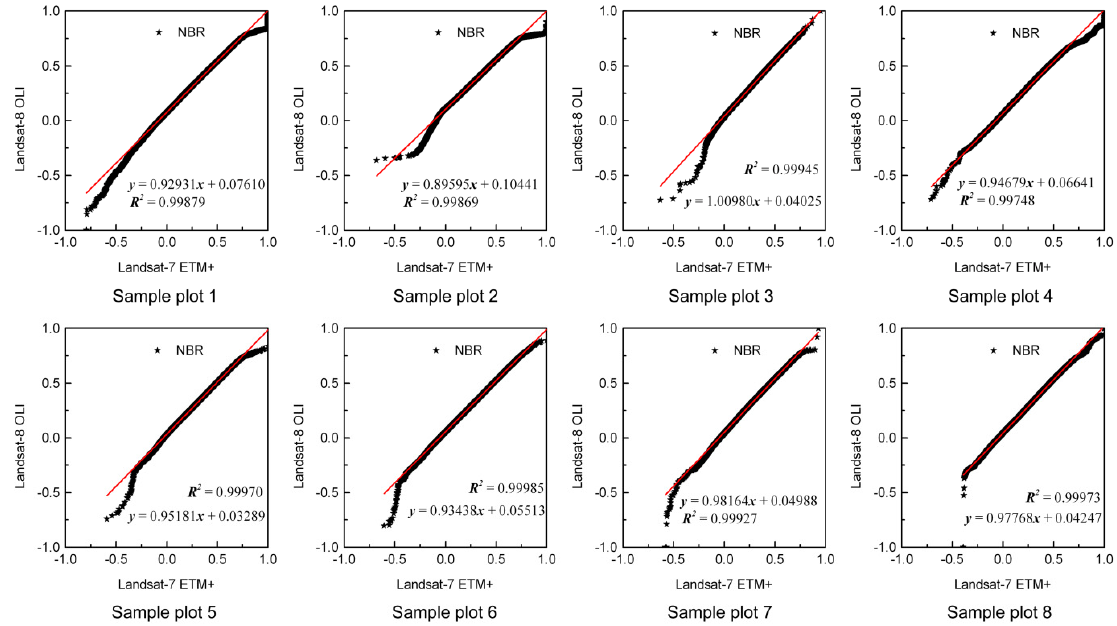
Figure 11. Statistical relationship between Landsat-7 ETM+ and Landsat-8 OLI NBR values for the eight sample plots. The linear regression equation and R 2 value are given in each plot. The red solid line refers to the linear fitting